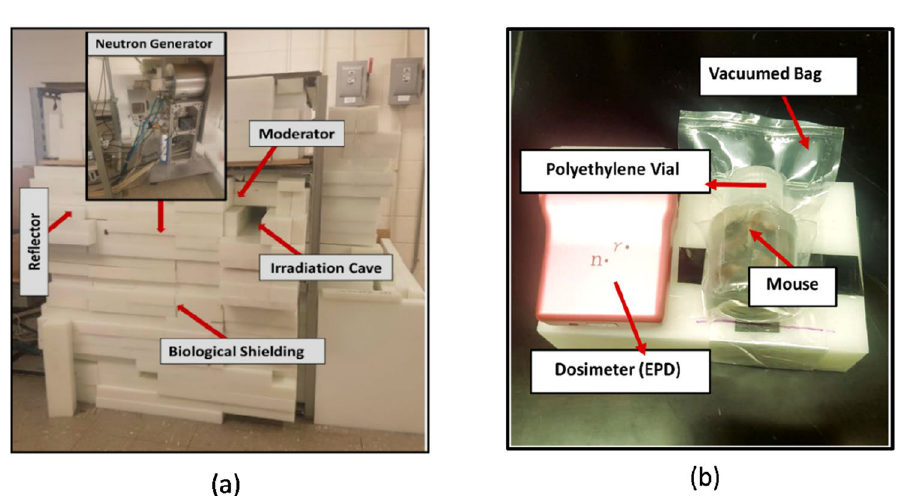
Figure 6. (a) The experimental setup made of irradiation assembly based on neutron generator to measure potassium concentration (b) mice sample before irradiation. Mice samples were placed inside the irradiation cave shown in (a) for the